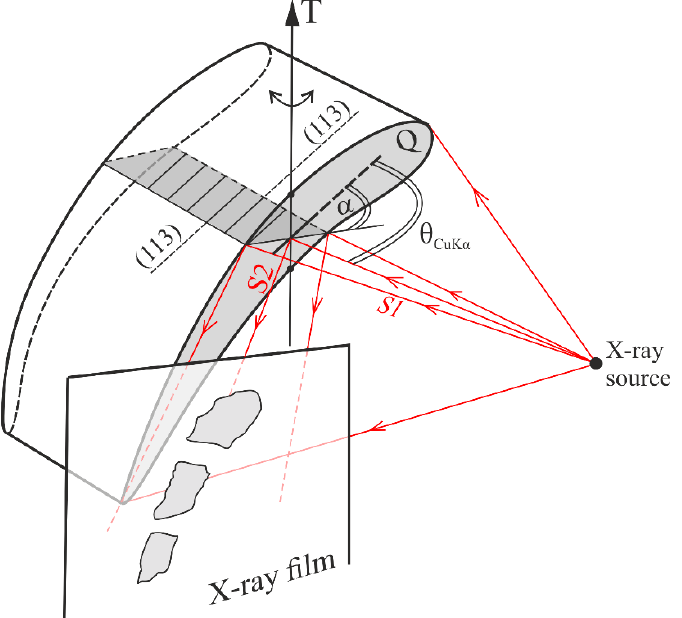
Figure A1. Diagram presenting the geometric arrangement of the X-ray source, sample and X-ray film for the X-ray topography method with the oscillation. S1—Incident divergent beam, S2—diffracted beam.